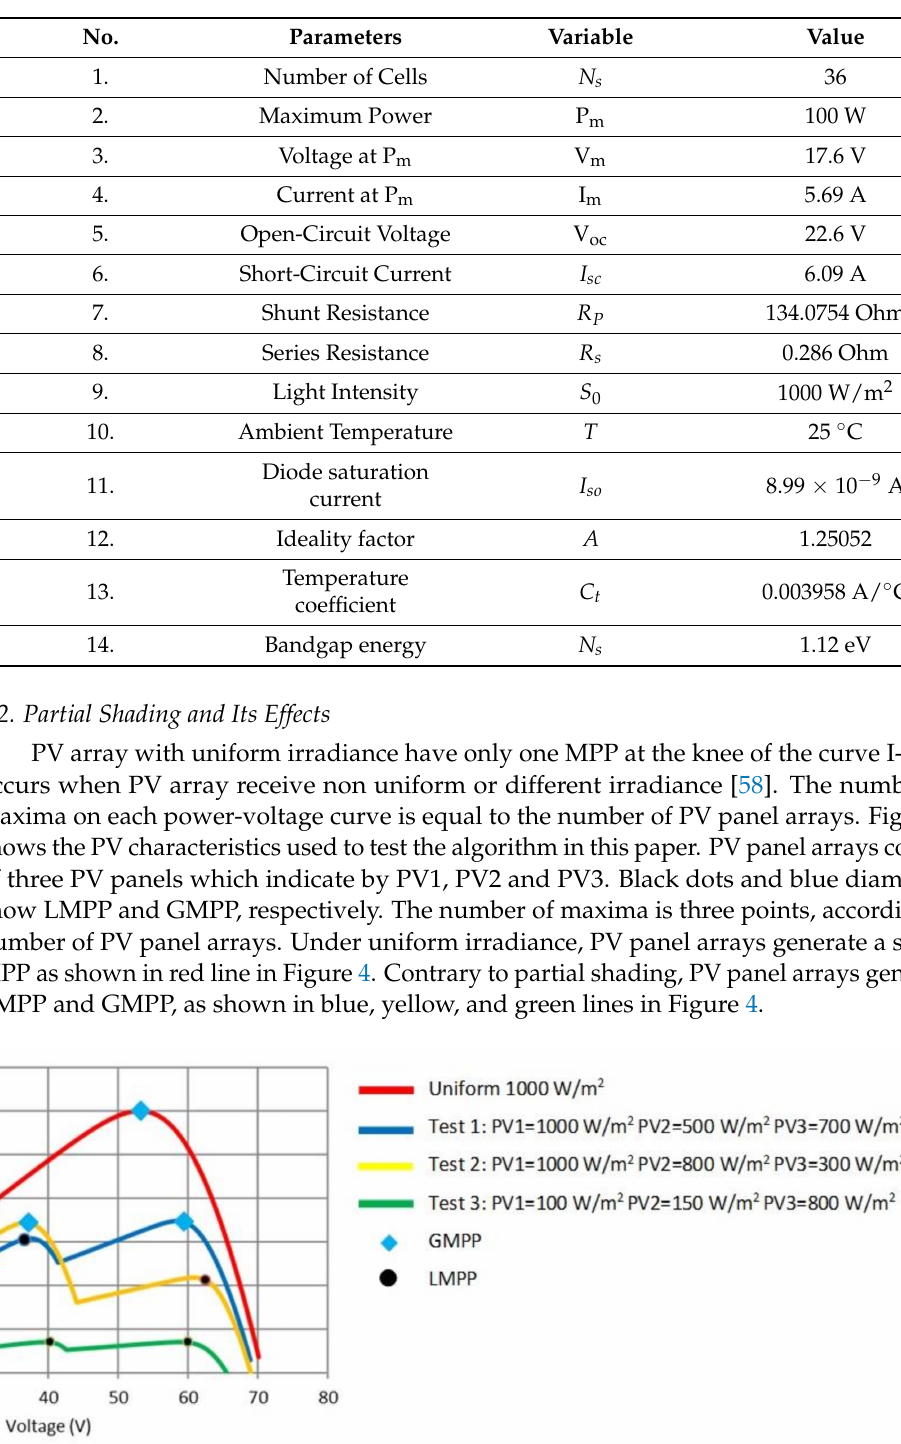
Table 2. PV panel specifications.